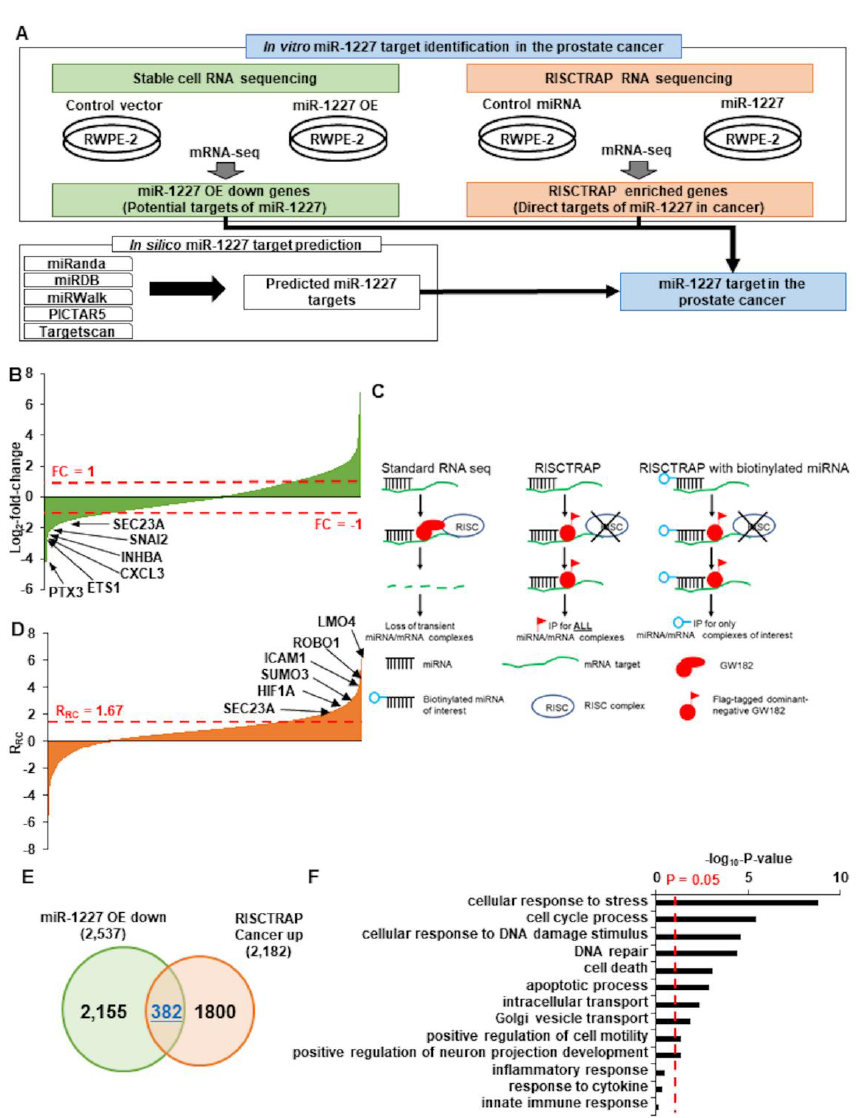
Figure 2. Identification of miR-1227 targets. ( A ) Summary of the bioinformatics strategy used to identify miR-1227 targets. ( B ) Waterfall plot of putative miR-1227 targets, identified by stable cell RNA sequencing in RWPE-2 cells stably expressing miR-1227. Prostate cancer-related genes downregulated by miR-1227 are highlighted. ( n = 1) ( C ) Schematic of the modified RISCTRAP assay. In standard RNA sequencing, some mRNA targets are rapidly degraded by the miRNA and are, thus, not detectable by RNA sequencing. The RISCTRAP assay stabilizes mRNA-miRNA complexes with a FLAG-tagged dominant negative GW182 protein, trapping the mRNA-miRNA complexes in an inactive state. The cells are transfected with a miRNA of interest, and all mRNA-miRNA complexes are pulled down using FLAG for RNA sequencing. We modified this assay by transfecting the cells with a biotinylated miR-1227, which is used to specifically isolate the mRNA-miR-1227 complexes. ( D ) Waterfall plot of putative miR-1227 targets, identified by the modified RISCTRAP RNA sequencing. Select high confidence genes with an R RC over 1.67 that are altered in prostate cancer are highlighted. ( n = 1) ( E ) Overlap of the genes identified in the stable cell and RISCTRAP RNA sequencing experiments. Shared genes identified in both miR-1227 stable cell and RISCTRAP sequencing from cancer cells are in blue. ( F ) Gene ontology of the shared miR-1227 target